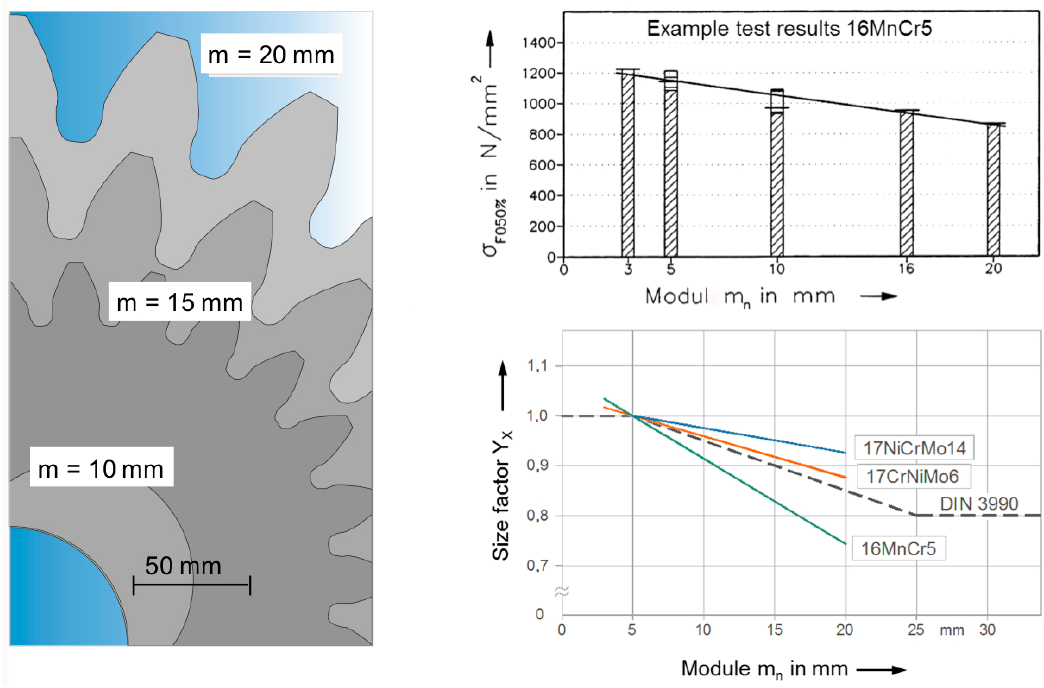
Figure 8. Influence of gear size on tooth root bending strength for gear materials with different hardenability; (left) examples of investigated test gears, (upper right) experimentally-determined tooth root endurance limit for material 16MnCr5 depending on gear size and (lower right) size factor for tooth root bending strength for different gear steels